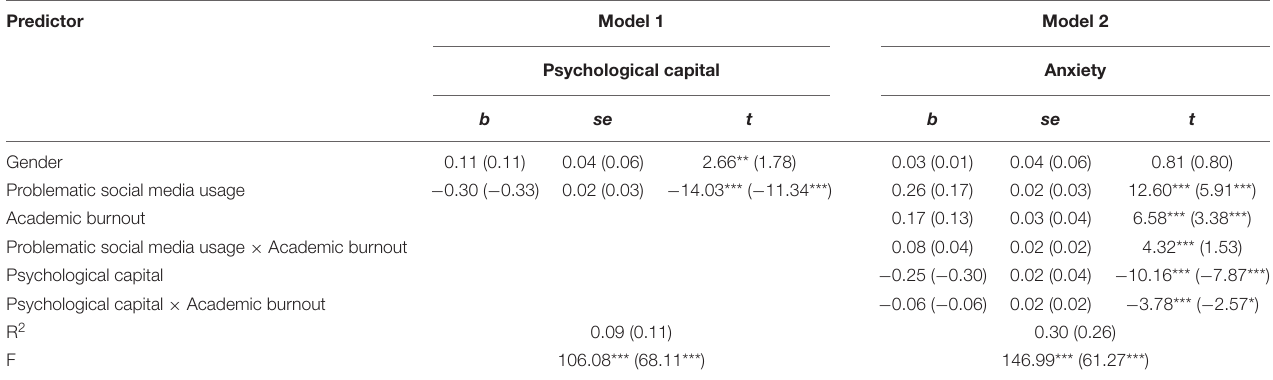
TABLE 3 | Testing the moderated mediation effect of problematic social media usage on